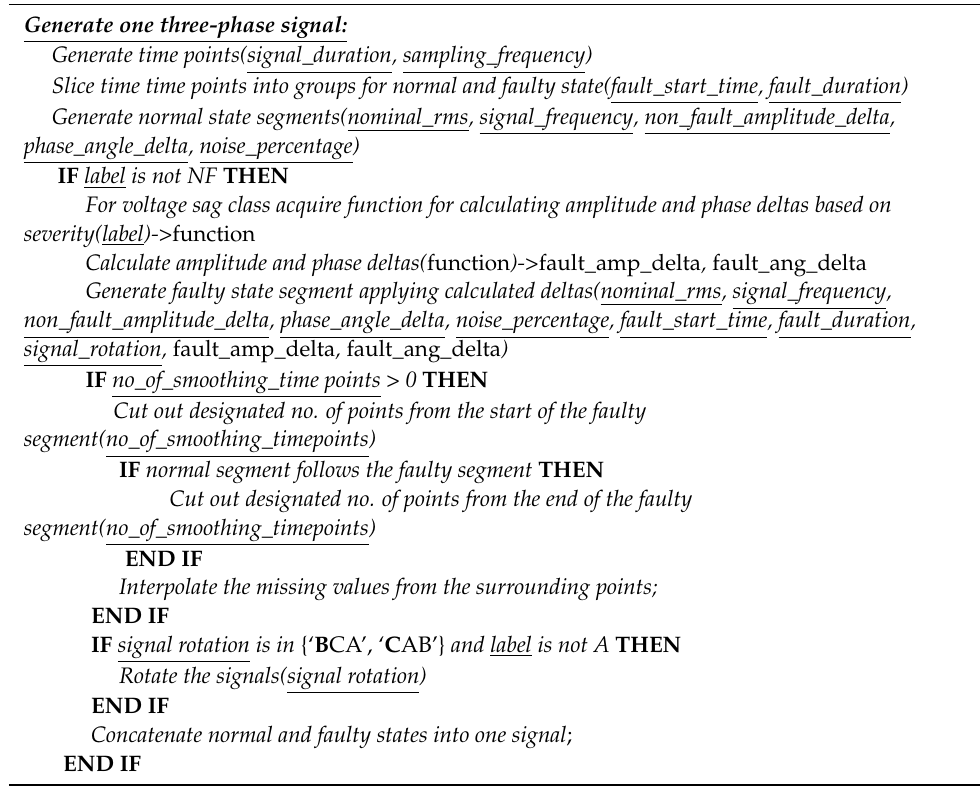
Algorithm A1 Step-by-step process of generating one synthetic signal.